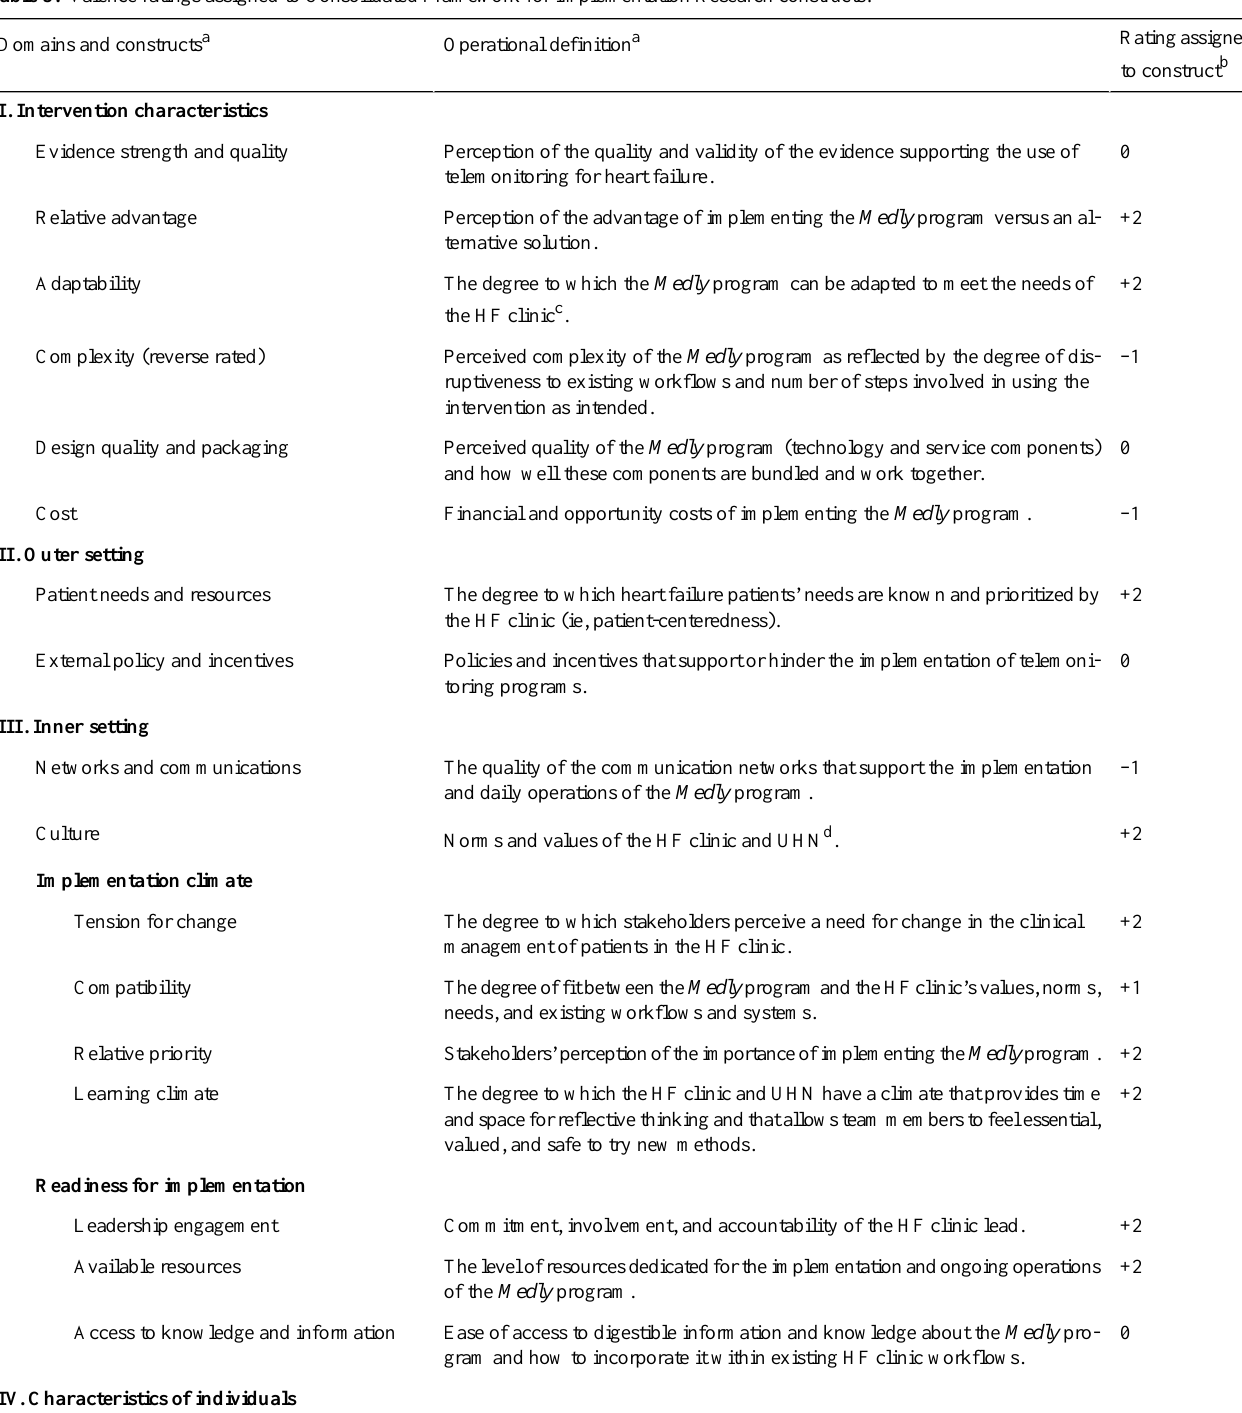
Table 3. Valence ratings assigned to Consolidated Framework for Implementation Research constructs.